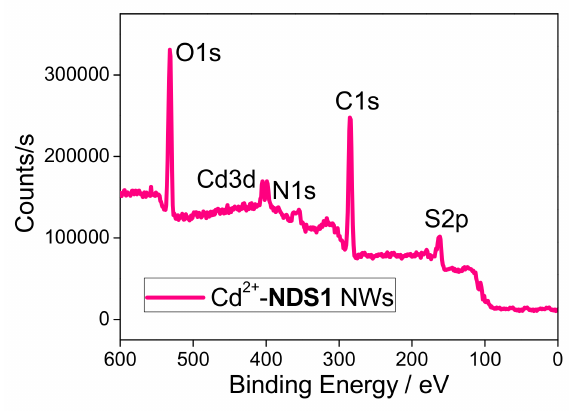
Figure 7. XPS spectrum of Cd 2+ - NDS1 NWs demonstrates the presence of Carbon (C1s), Nitrogen (N1s), Oxygen (O1s), Sulfur (S2p) and Cadmium (Cd3d)